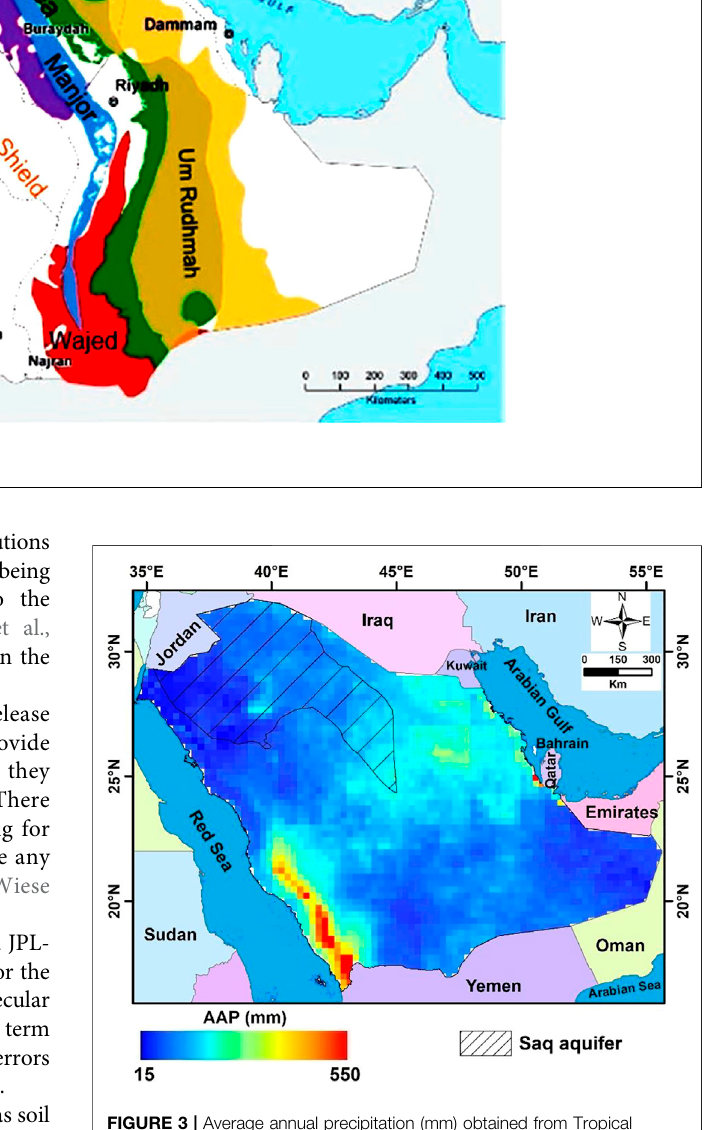
April 2002 to July